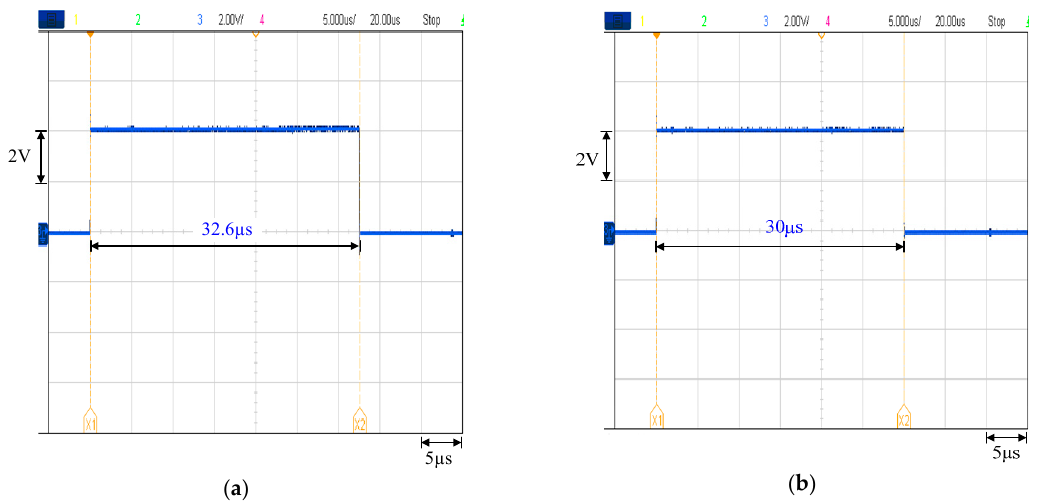
Figure 9. Calculation time of the IT2 T-S fuzzy and the IT1 T-S fuzzy systems: ( a ) IT2 T-S fuzzy; ( b ) IT1 T-S fuzzy.